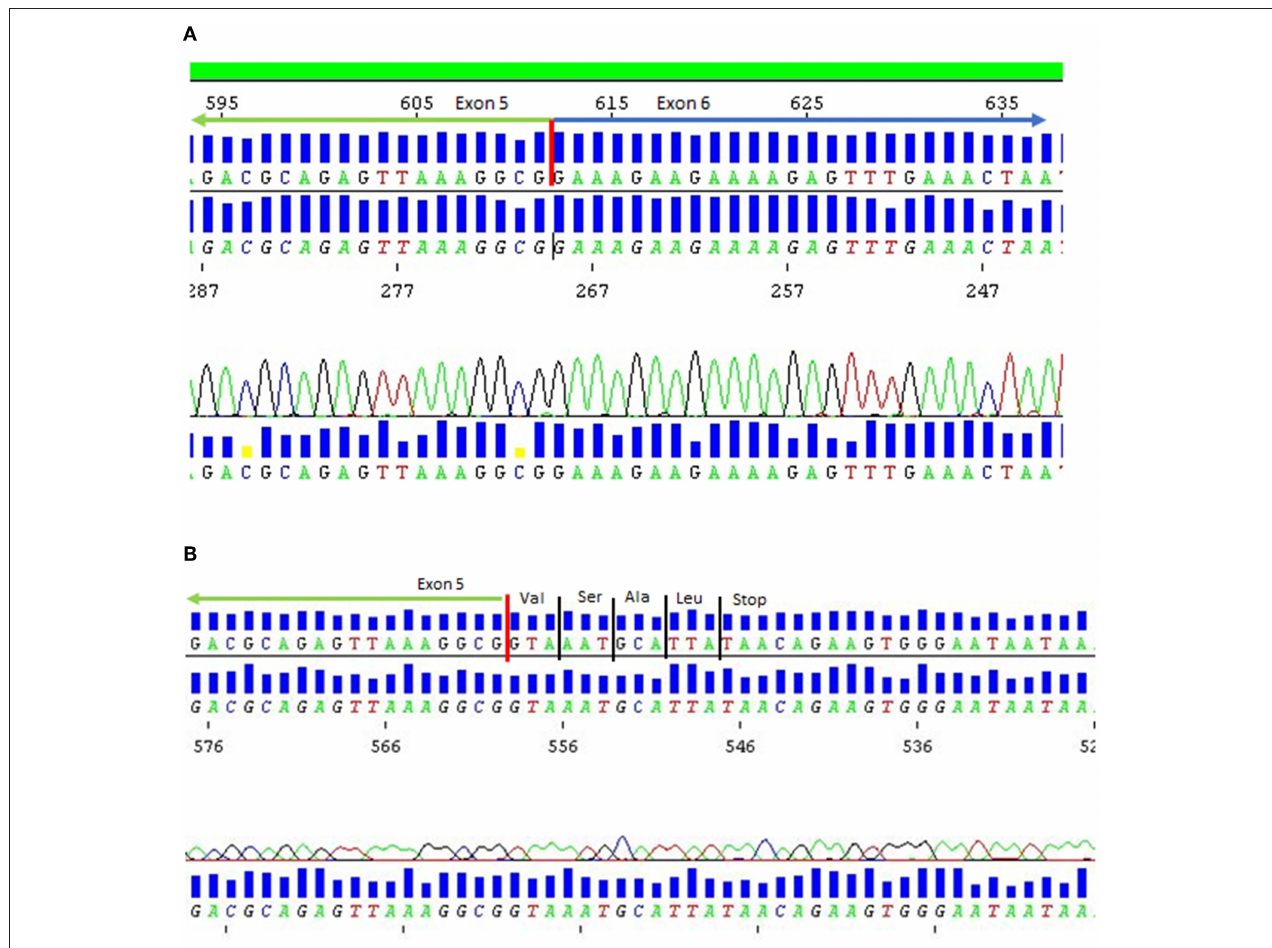
FIGURE 2 | DNA sequence chromatogram for patient 1. (A) Normal control mRNA. (B) Patient 1 mRNA showing loss of exon 5 donor splice site resulting in intron inclusion and premature termination of protein due to presence of stop codon in variant